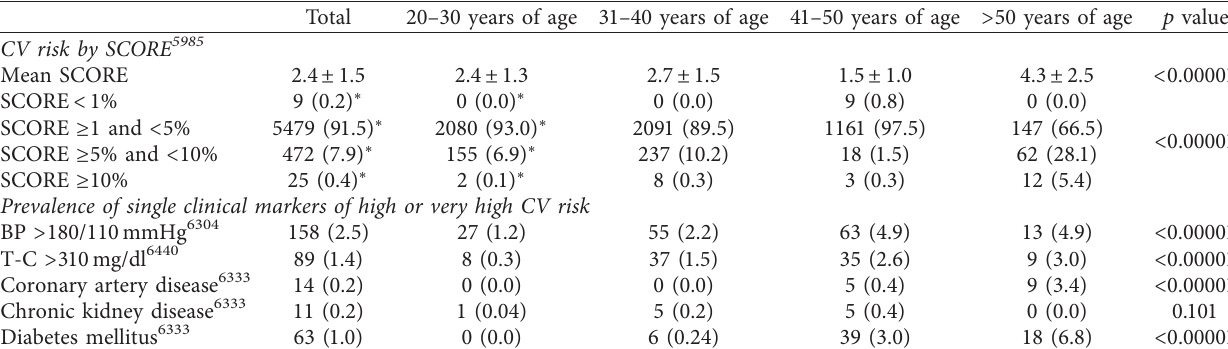
Table 4: Cardiovascular risk assessment and selected single risk factors by